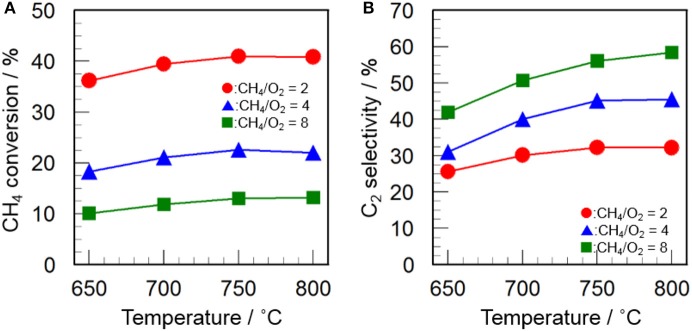
Effect of CH4/O2 ratio on (A) CH4 conversion and (B) C2 selectivity in the OCM reaction over CeO2(3)/Y2O3(CP). (Red circles) CH4/O2 = 2, (blue triangles) CH4/O2 = 4, (green squares) CH4/O2 = 8.